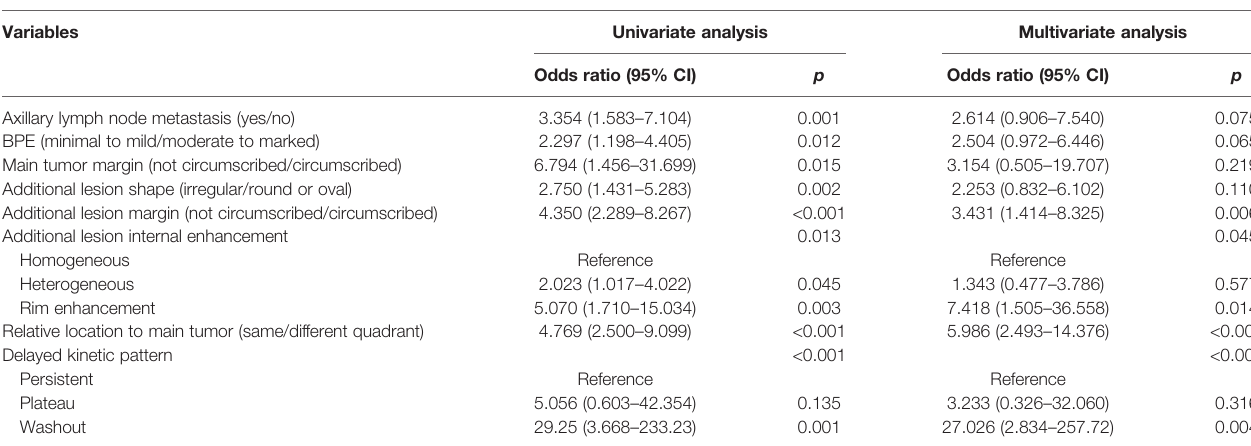
TABLE 2 | Logistic regression analysis